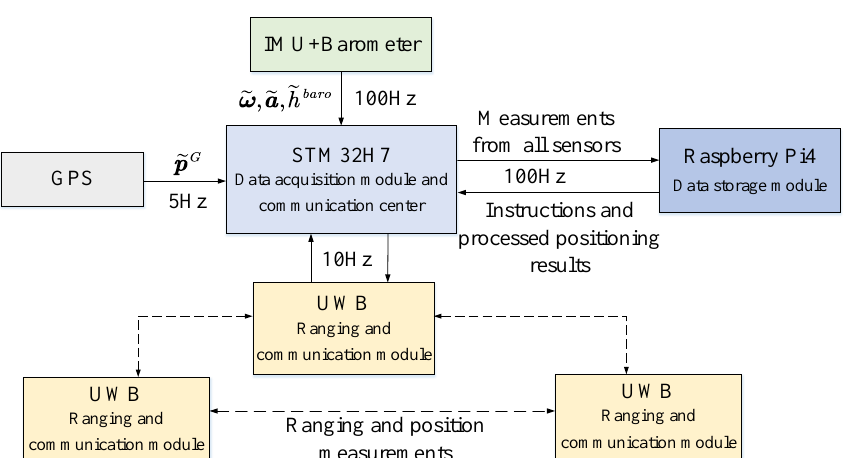
Figure 9. UAV platform.